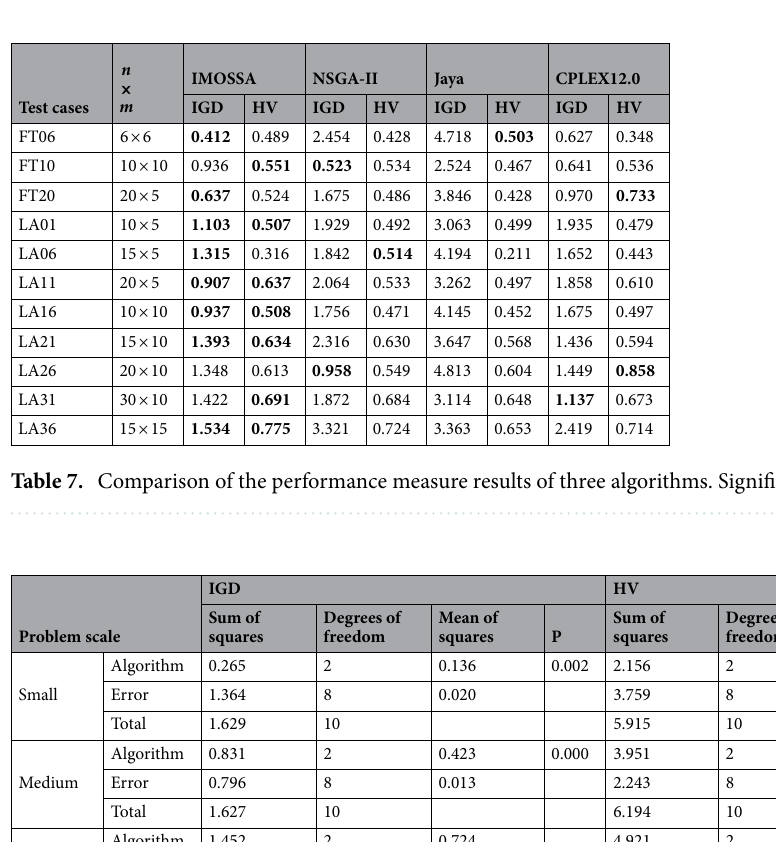
Problem scale Algorithm 0.265 Small Algorithm 0.831 Medium Algorithm